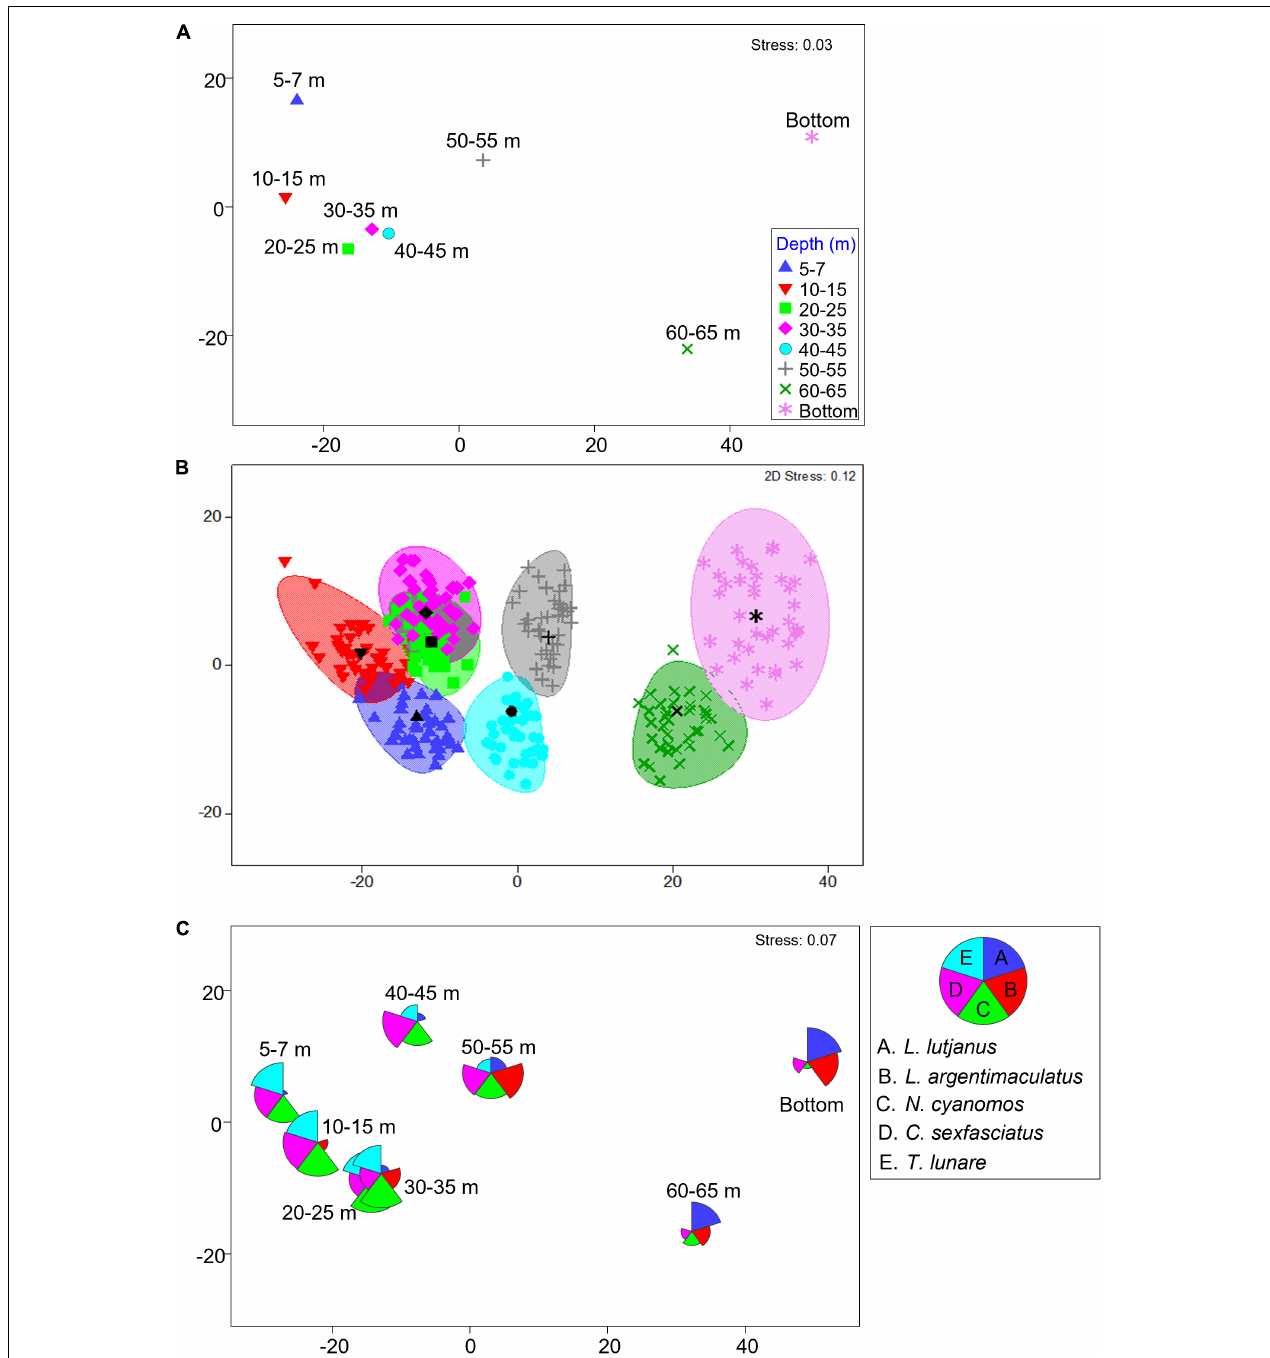
FIGURE 2 | Metric MDS plots of fish assemblage with platform depth, displaying (A) of centroids, (B) centroids and bootstrapped sampling with 95% confidence interval ellipses, and (C) centroids with species overlays of dominant species as defined by SIMPER. For all plots data were Fourth Root transformed and used a Bray Curtis dissimilarity measure were